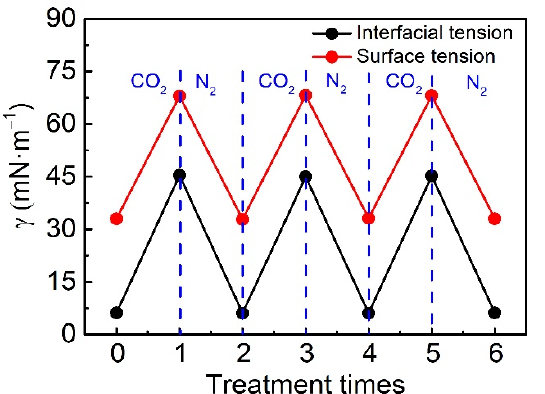
Figure 4. The variation in the surface tension and interfacial tension of the OA/cyclen (mol/mol, 4:1; (OA)= 0.5 mol/L) aqueous solution during alternate CO 2 /N 2 bubbling at 25 °C.